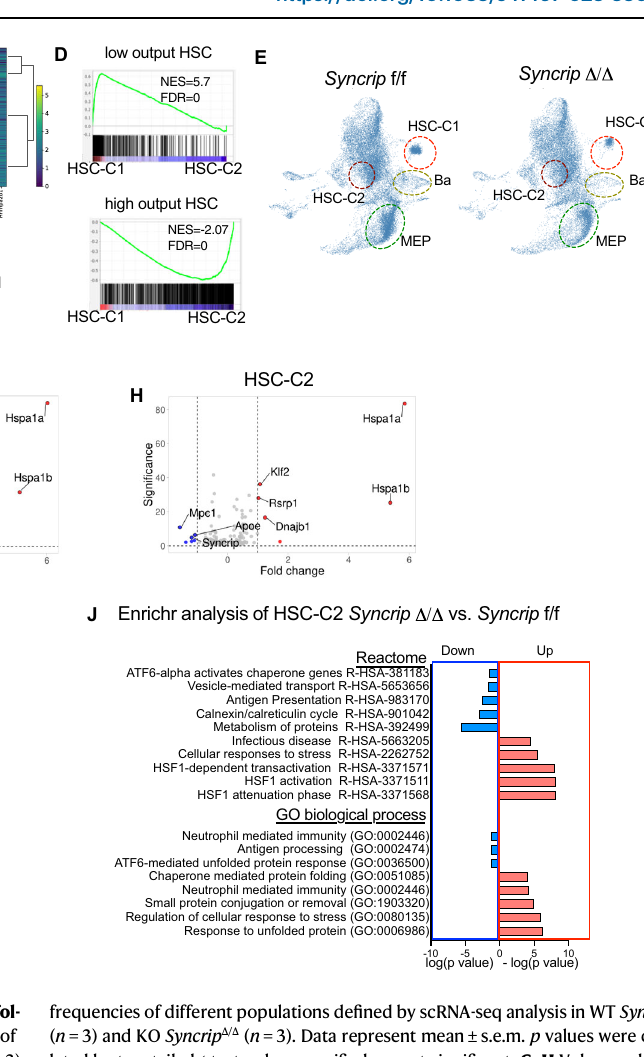
frequencies ofdifferent populations de fi ned by scRNA-seq analysisin WT Syncrip f/f ( n =3) and KO Syncrip Δ / Δ ( n =3). Data represent mean±s.e.m. p values were calcu- lated by two-tailed t test unless speci fi ed. ns not signi fi cant. G , H Volcano plots showinggenesdifferentiallyexpressedbetween Syncrip f/f vs. Syncrip Δ / Δ withinHSC- C1 and HSC-C2 clusters. The most differentially expressed genes are highlighted. I Enrichr analysis for GO biological processes and Reactome enrichment of sig- ni fi cant (FDR<0.05) downregulated and upregulated genes within the HSC-C1 population of Syncrip Δ / Δ vs. Syncrip f/f . X-axis: -log 10 (p value). Enrichment of down- regulatedtargetswasdepictedasnegativelog 10 (p)andenrichmentofupregulated targetswasdepictedaspositivelog 10 (p). p -valueswerecalculated byFisher ’ sexact test. J Enrichr analysis for GO biological processes and Reactome enrichment of signi fi cant (FDR<0.05) downregulated and upregulated genes within the HSC-C2 population of Syncrip Δ / Δ vs. Syncrip f/f . X-axis: -log 10 ( p value). p -values were calcu- lated by Fisher ’ s exact test. Source data are provided as Source Data